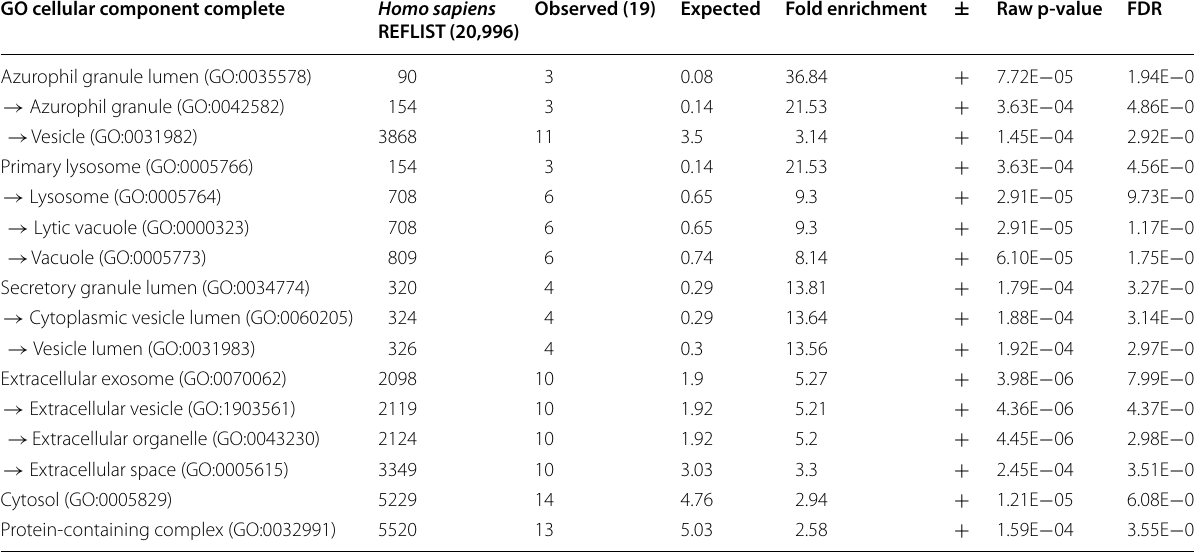
Presented hierarchically with the most specific subclass first, with its parent terms directly below it. Related classes in an ontology are grouped. Results shown for false discovery rate (FDR) < 0.05. (geneontology.org, 22.5.20)